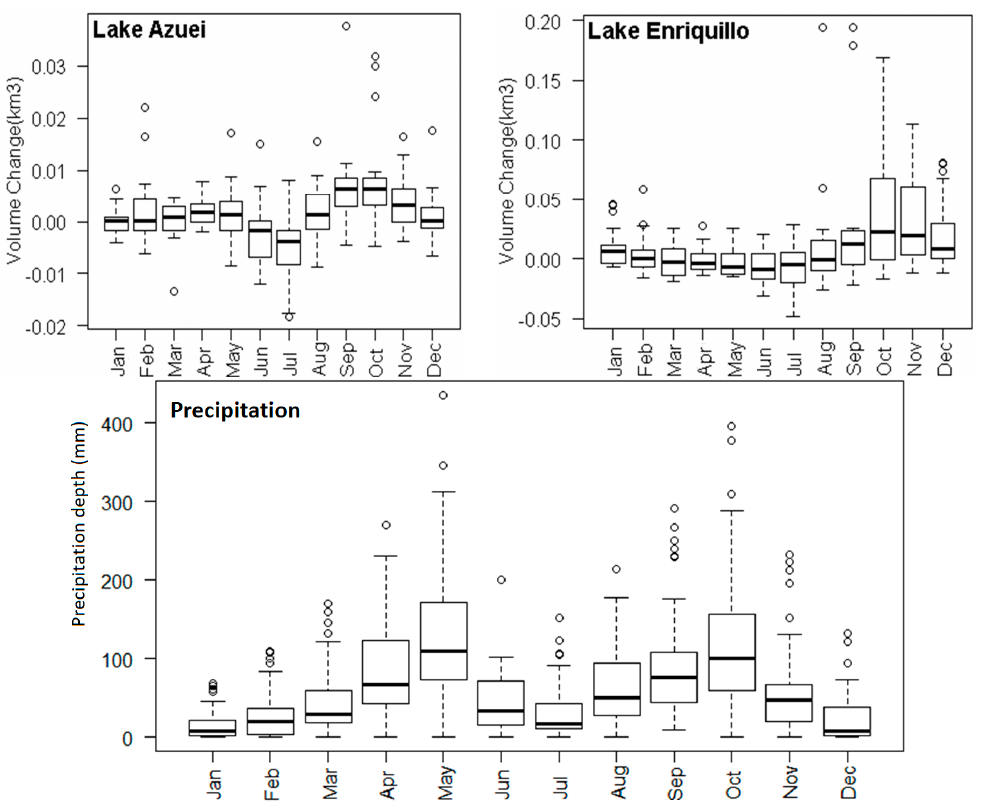
Figure 9. Top: monthly Variation of lake’s volume change for Lake Enriquillo and Lake Azuei [the data used to graph boxplots is imputed monthly volume time series for the years of 1996 to 2014]; Bottom: monthly precipitation pattern at Jimani Station (1951–2015).